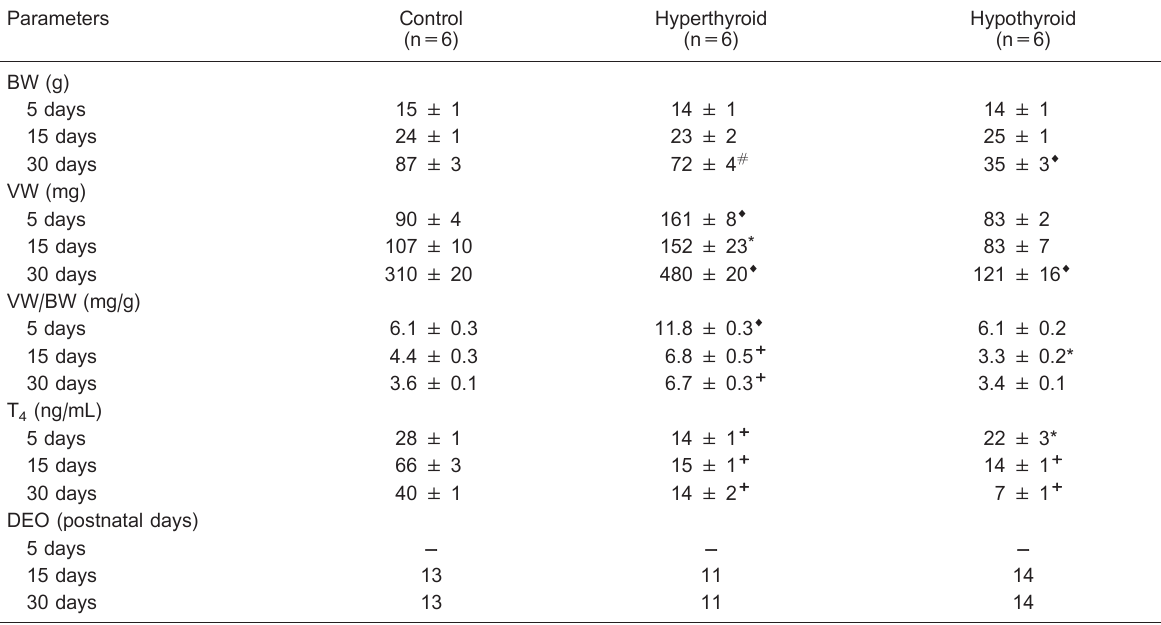
Table 1. Effect of thyroid hormone on development of body weight, ventricular weight, VW/BW ratio, DEO, and serum T 4 concentrations of T 3 - (4 m g/100 g, sc ; hyperthyroid group) and PTU- (5 mg/100 g, sc ; hypothyroid group) treated rats for 5, 15, and 30 days.